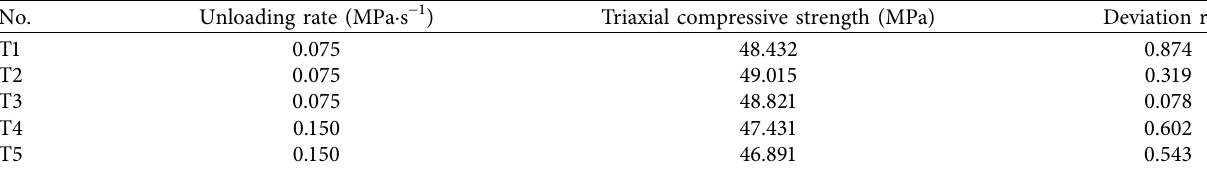
Table 4: Verification of experimental results.